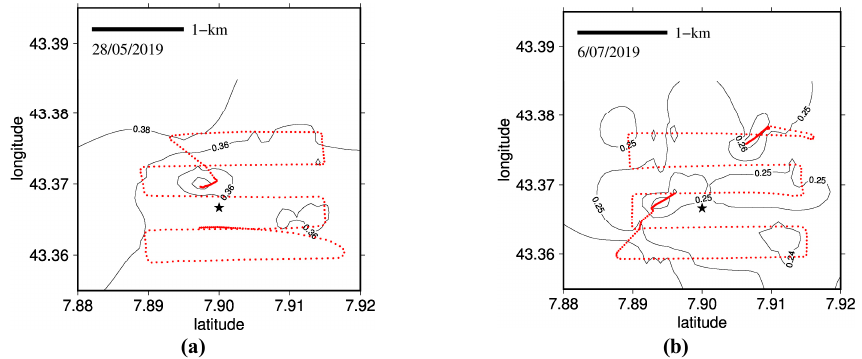
Figure 9. Example of grid surveys performed (a) in May and (b) in July 2019. The red dotted line shows the ship track, and the black curves are the contours of the chlorophyll- a fluorescence (values are indicated on the contour lines).